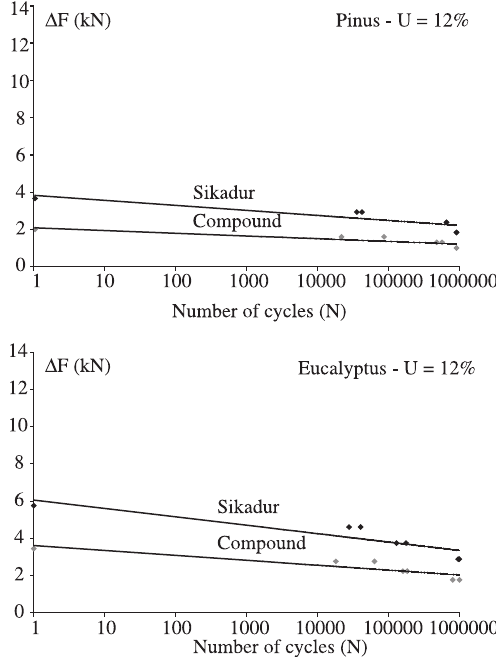
Figure 5. Fatigue performance of the epoxy adhesives – Moisture = 12%.